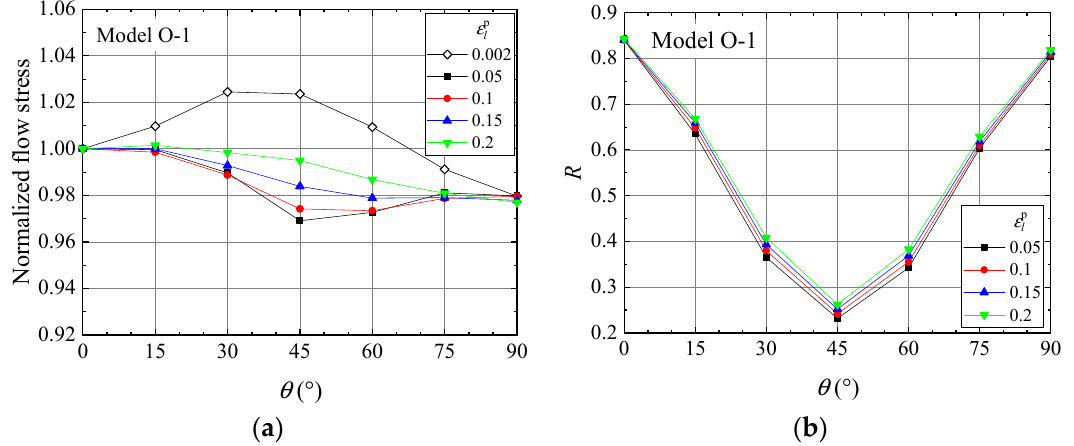
Figure 5. Crystal plasticity prediction with model O-1. ( a ) Normalized flow stress and ( b ) R value.